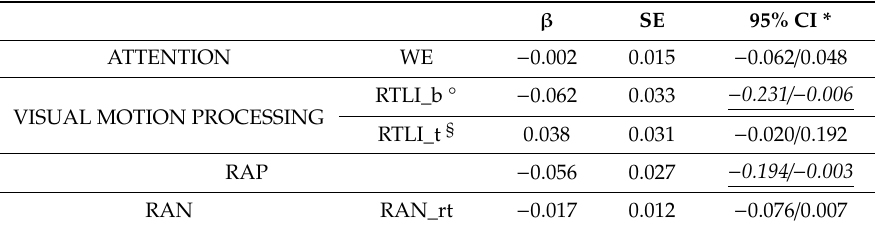
Table 4. Specific indirect e ff ects of endophenotypes (Eps) from ROBO1 -rs9853895 to reading (standardized β s and SEs are reported).